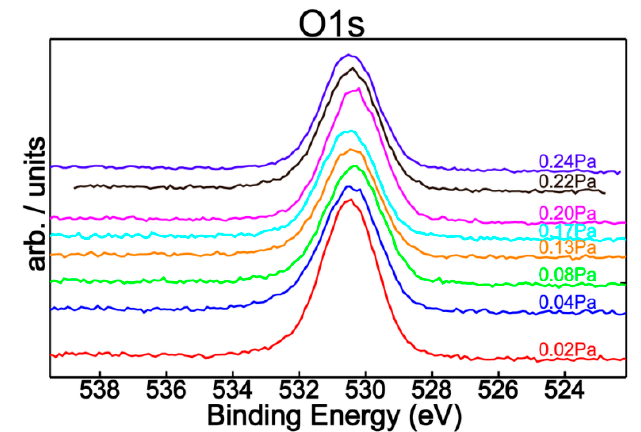
Figure 6. O1s XPS superimposed spectra for different reactive gas partial pressures.